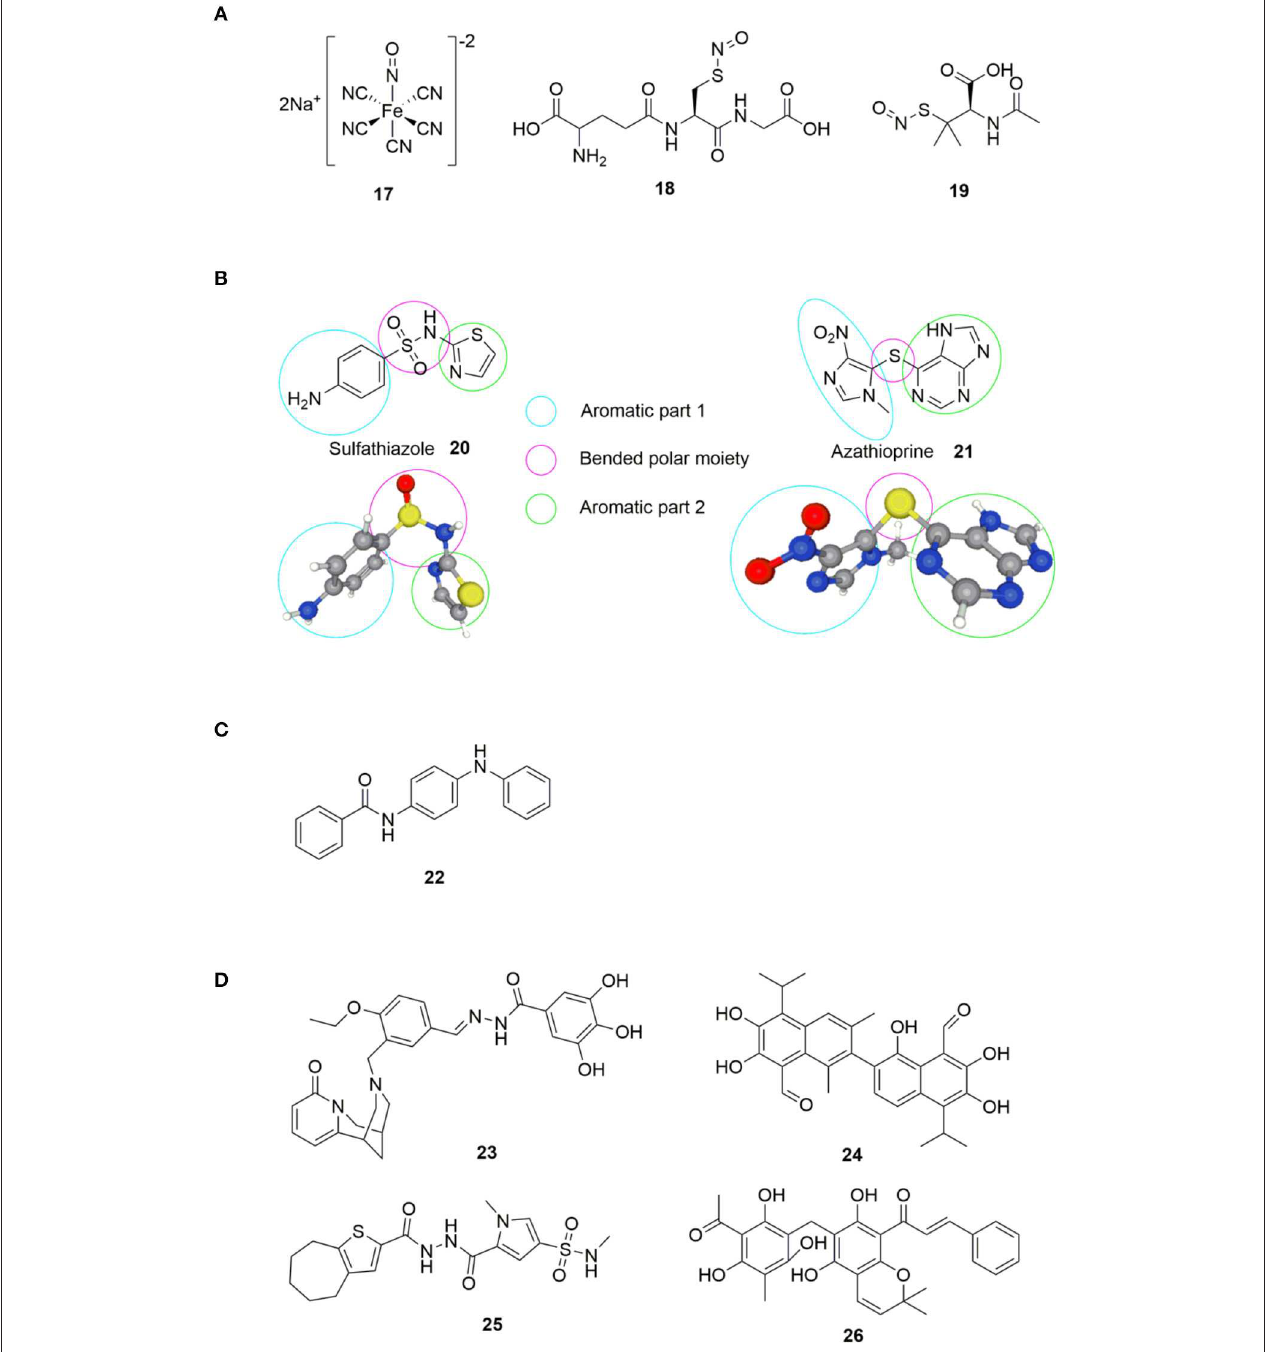
FIGURE 5 | (A) NO donors exerting biofilm-inhibitory effect (Barraud et al., 2006). (B) Sulfathiazole 20 and azathioprine 21 ; small molecules found to interfere with c-di-GMP biosynthesis by the group of Antoniani et al. (2010, 2013). (C) Compound identified as DGC inhibitor (DI) by Sambanthamoorthy et al. (2014). (D) Inhibitors of DGC discovered by Sambanthamoorthy et al. (2014).